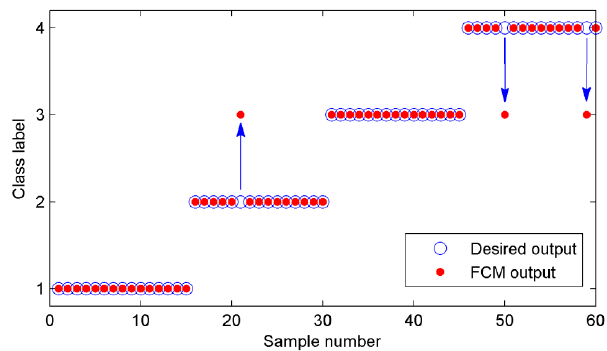
Figure 7. The classification results of FCM clustering with EMD method.